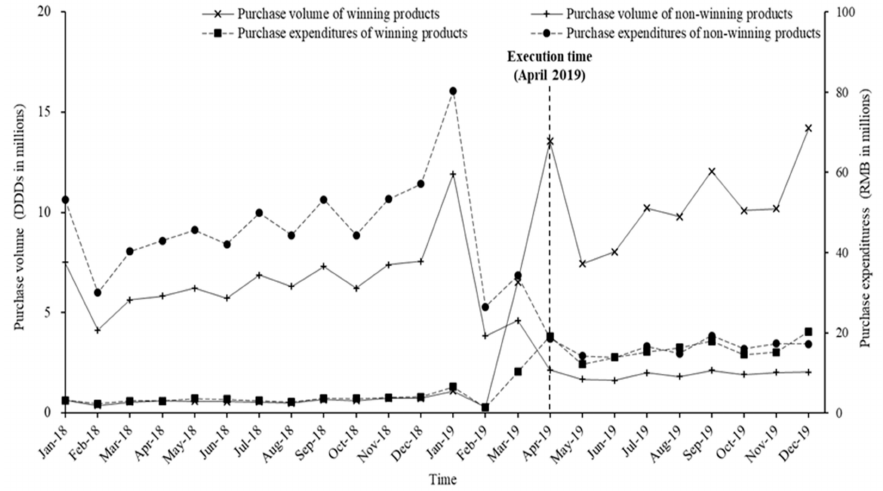
Figure 1. Monthly trends of volume and expenditures of winning and non-winning products among “4 + 7” policy-related drugs from January 2018 to December